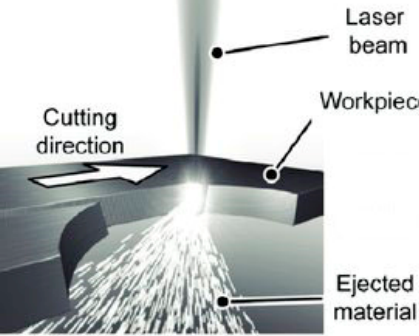
Figure 1. Fusion cutting mechanism [21]. Table 1. Cutting parameter levels for polyethylene (PE), polypropylene (PP), and polycarbonate (PC) in the fusion cutting mechanism [22] .